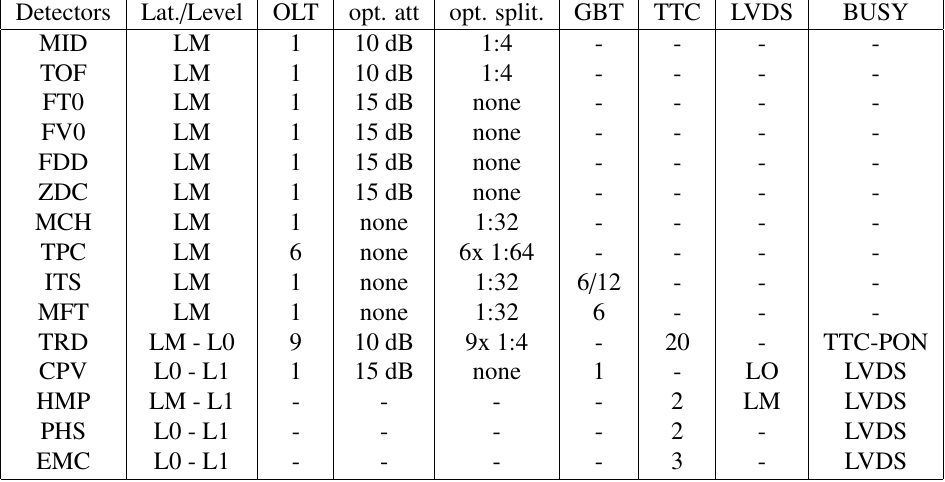
Table 2. A summary of operating levels, number of OLT links with optical attenuation and splitter, number of GBT and TTC links, LVDS with the level it operates on, and how the busy is propagated back to CTP for various ALICE